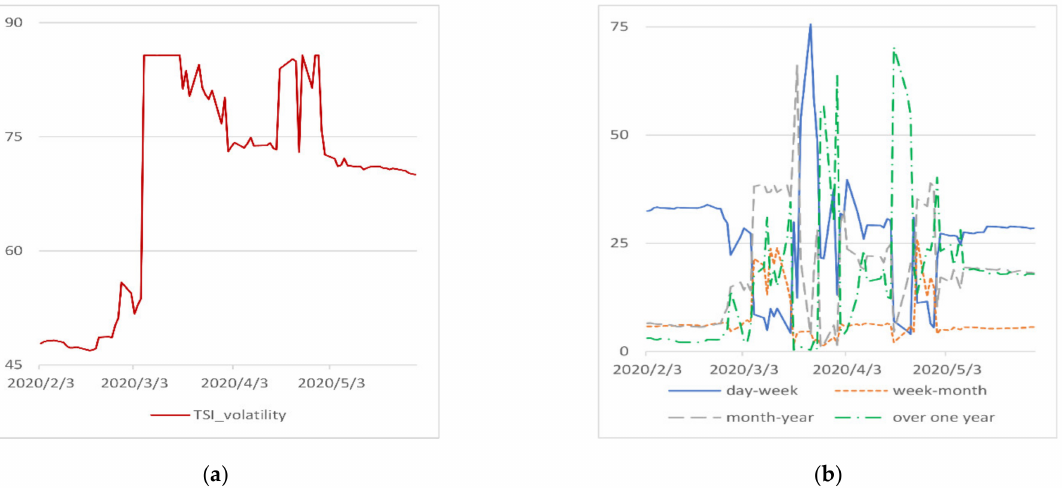
Figure 9. Total spillover of the price volatility system during COVID-19. ( a ) total volatility spillover. ( b ) frequency decomposition of volatility